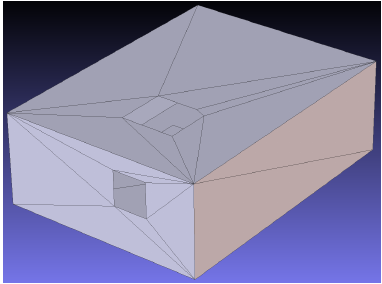
Figure 11. Mesh obtained from a synthetic point